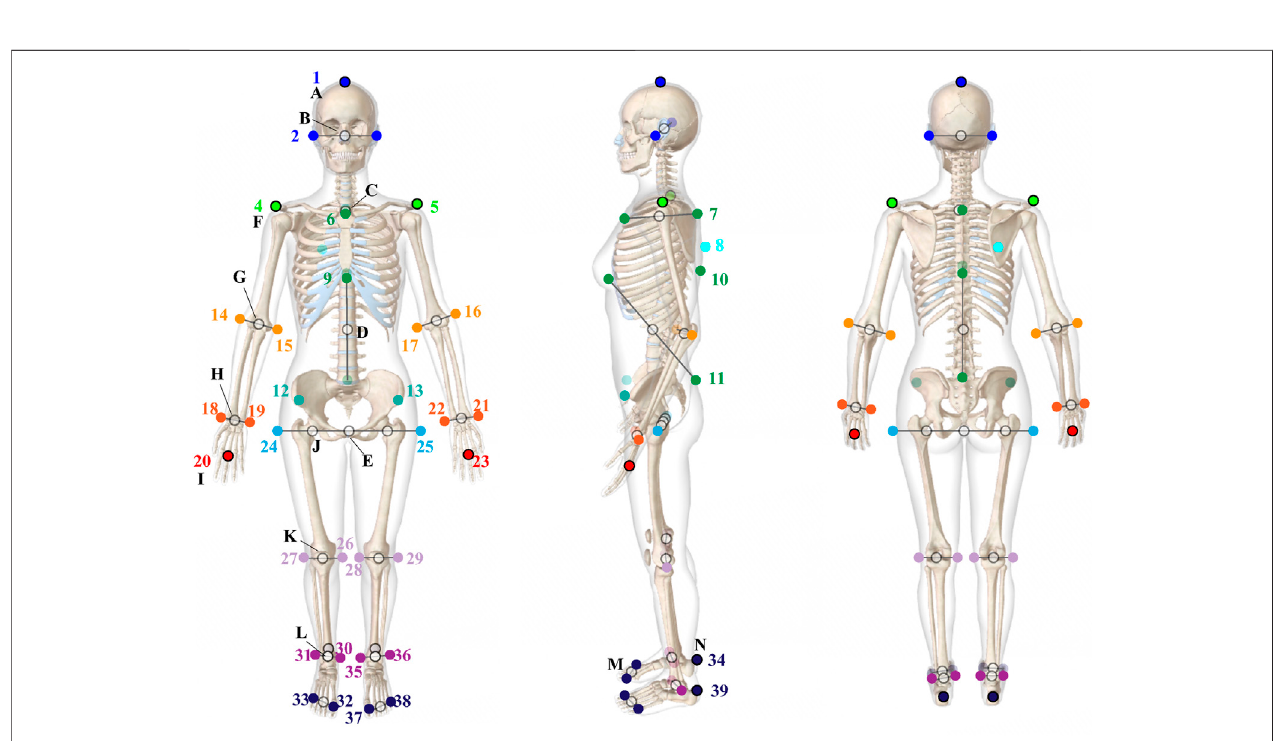
FIGURE 5 | De fi nitions of 39 retrore fl ective markers attached on the subject ’ s body for the motion measurement.